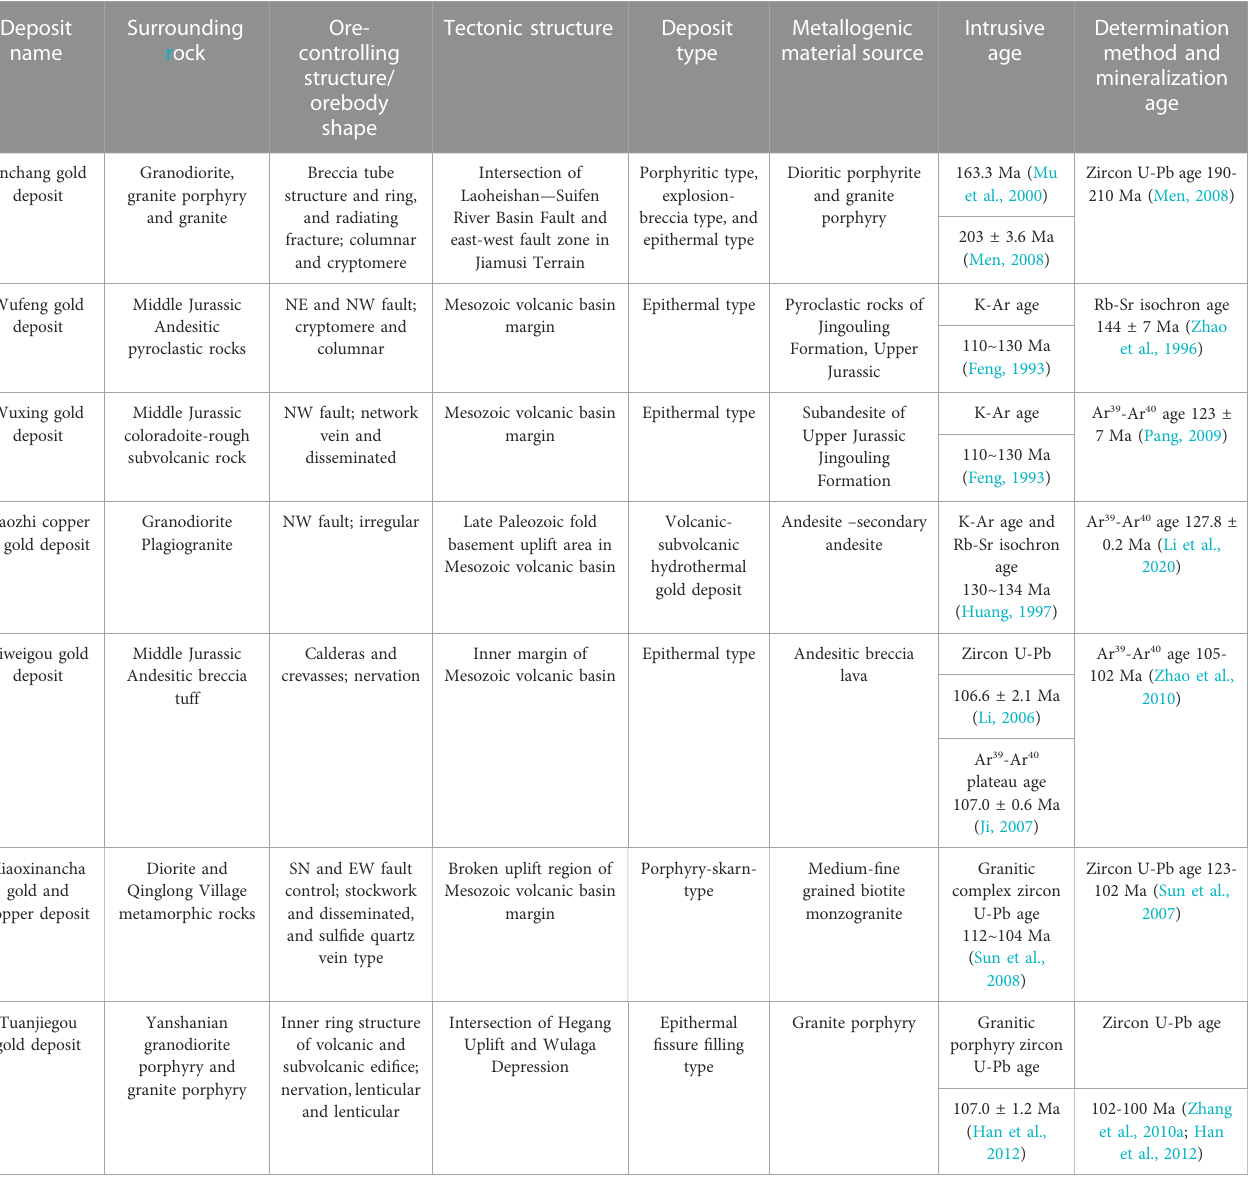
TABLE 3 Characteristics of deposits in the study